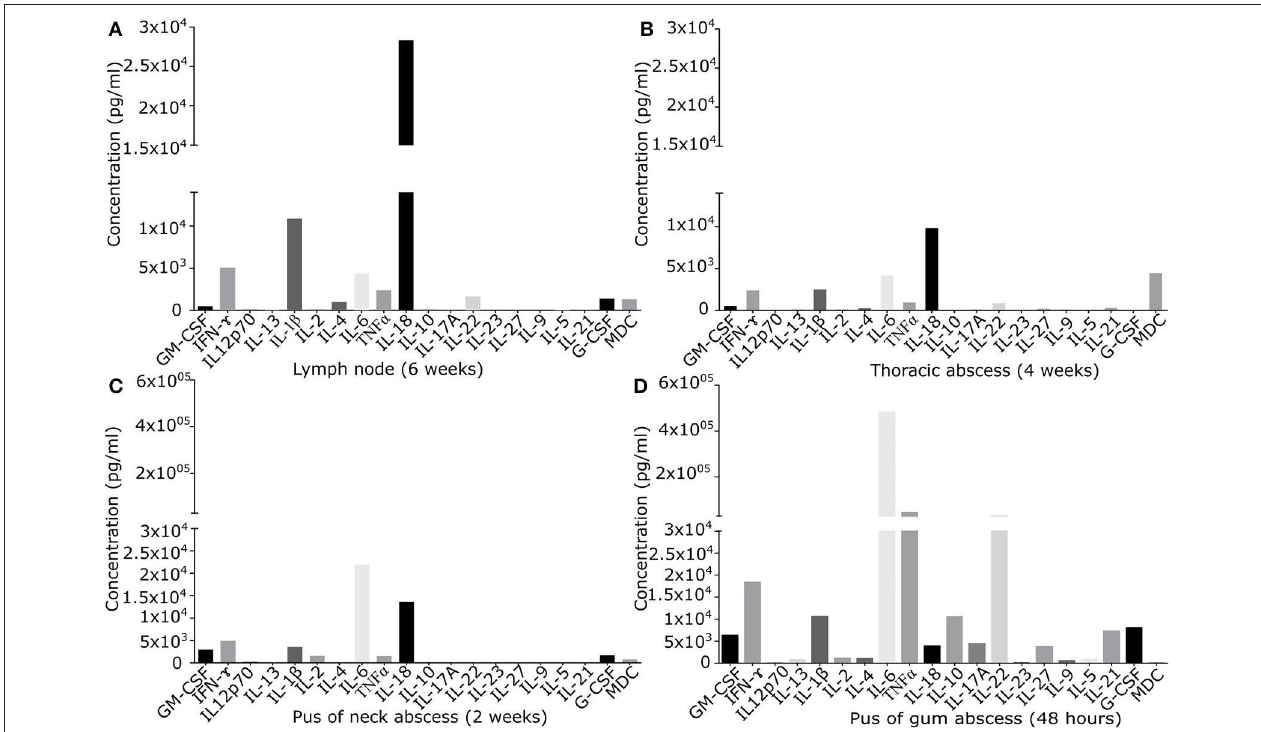
FIGURE 1 | Quantification of signaling molecules in inflamed primary derived human CGD material of (A) lymph node of the neck present since 6 weeks, (B) sub-muscular thoracic abscess inflamed since 4 weeks, (C) pus from subcutaneous abscess of the neck present since 2 weeks, (D) puss from gingival abscess present since 48h. In the supernatant of primary derived smashed tissues signaling molecules were quantified by Multiplex immunoassay. Results are given in pg/ml of local undiluted concentrations. Tissue types and duration of inflammation at the time of the analysis are indicated.